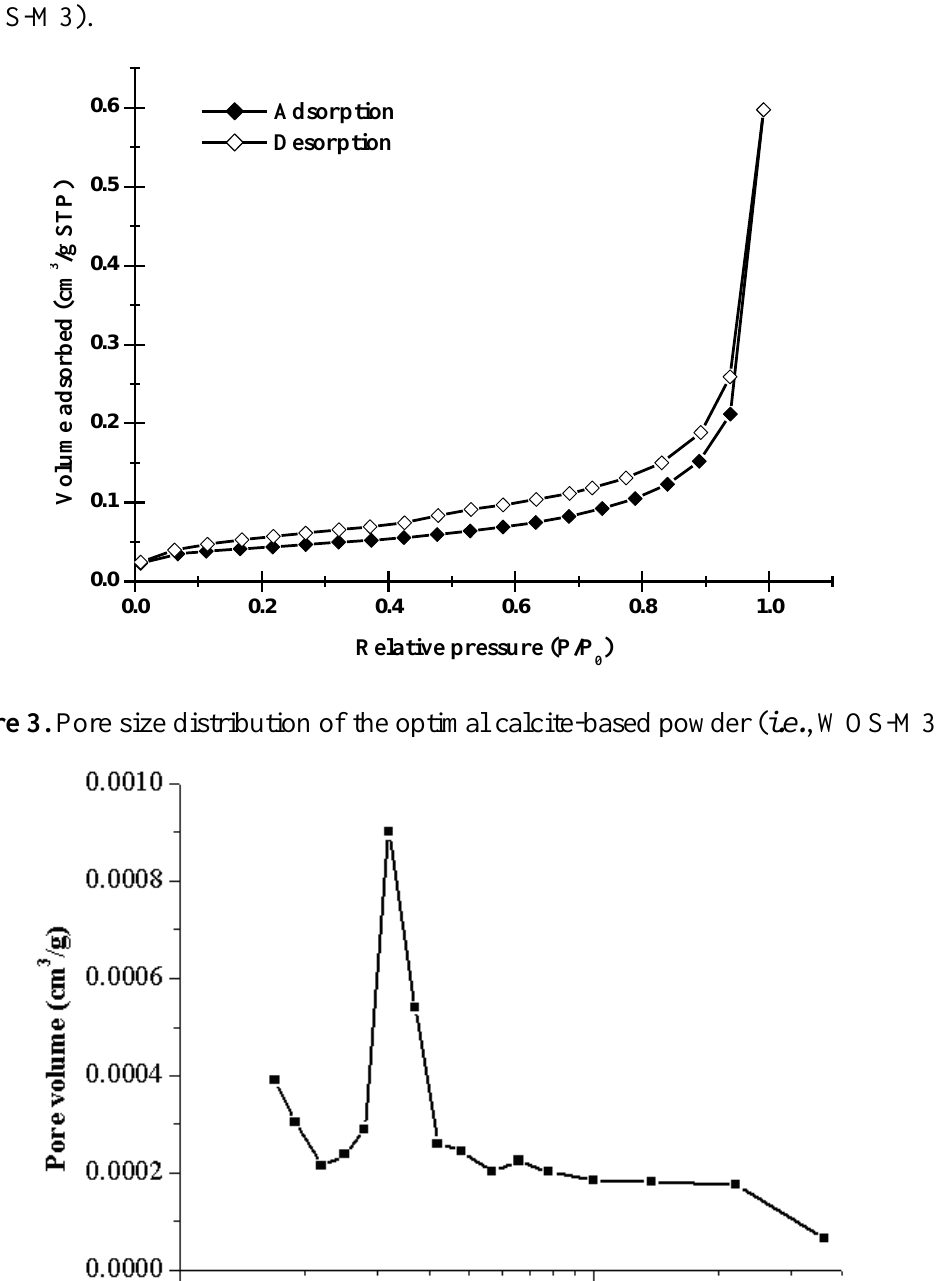
Figure 2. N adsorption-desorption isotherms of the optimal calcite-based powder 2 ( i.e. , WOS-M3).